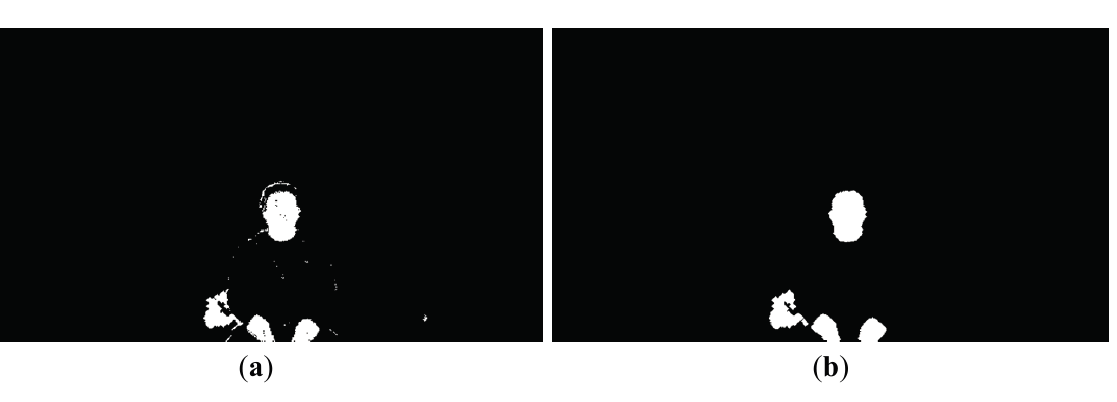
Figure 4. Color filtering examples: ( a ) Binary image after color filtering; ( b ) Resulting image after morphological operations.